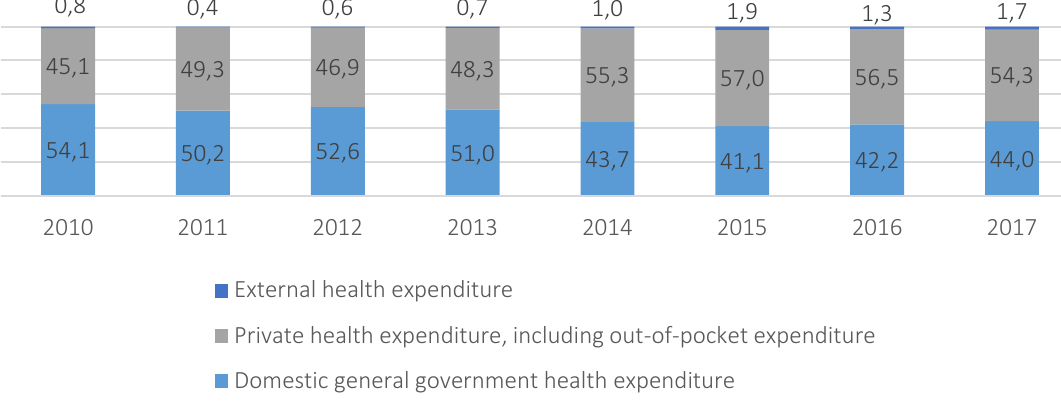
Figure 9. Structure of current health expenditure by financial resources, Ukraine,